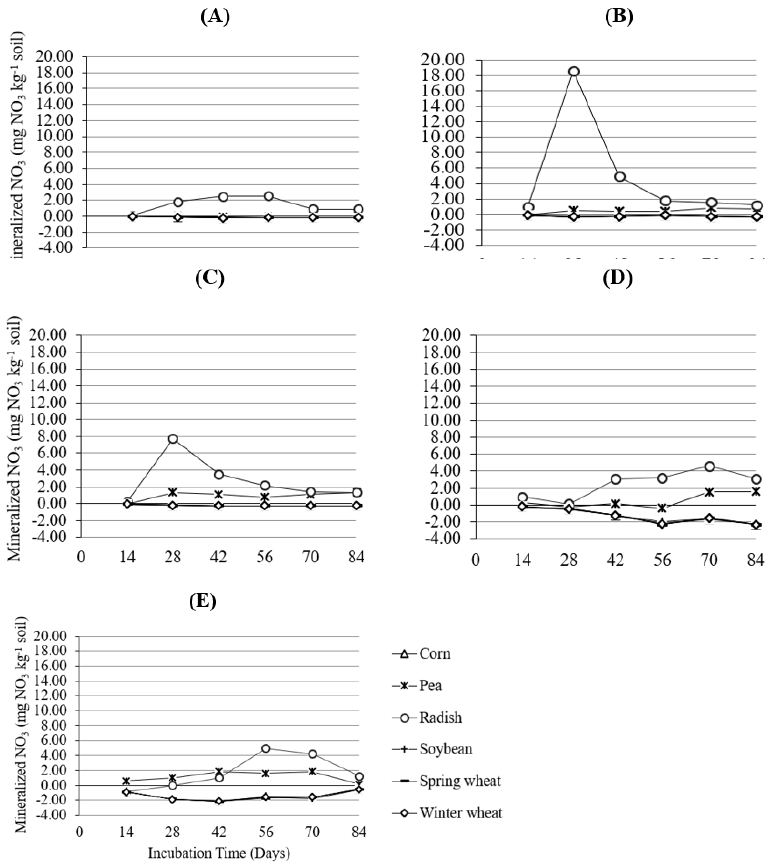
Figure 4. First incubation ( A ), second incubation ( B ), third incubation ( C ), fourth incubation ( D ), and fifth incubation ( E ) cycle daily mean mineralization/immobilization of soil NO 3 -N.